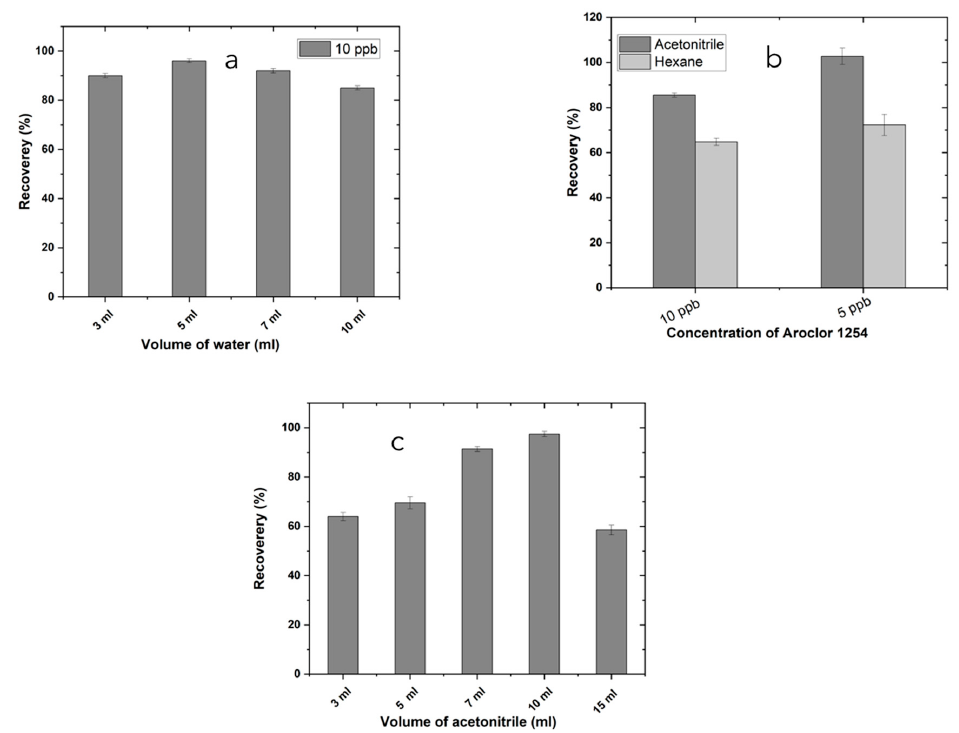
Figure 2. ( a ) The e ff ect of water addition on extraction e ffi ciency for the target Aroclor 1254 at 10 ng/mL; ( b ) the e ff ect of acetonitrile and hexane as extraction solvents for the target Aroclor 1254 at 5 ng/mL and 10 ng/mL (n = 3); ( c ) the e ff ects of di ff erent solvent volumes for the target Aroclor 1254 at 10 ng/mL (n = 3).